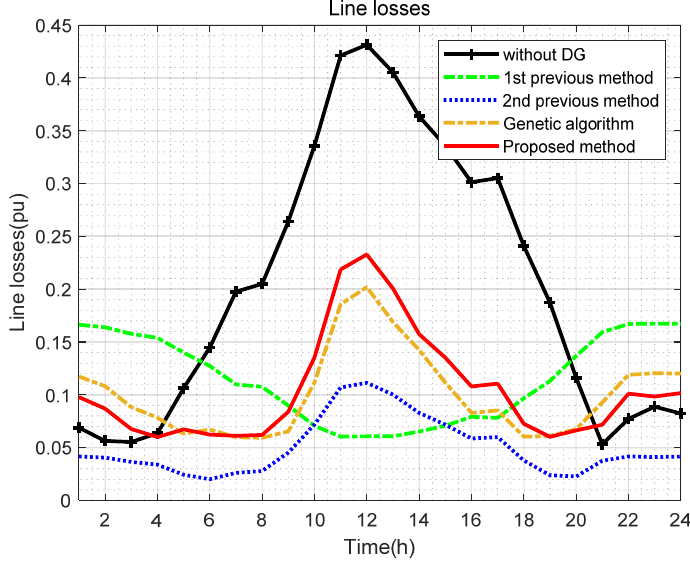
Figure 11. Voltage profile (the IEEE 14-bus test feeder). All the bus locations for 24 h.